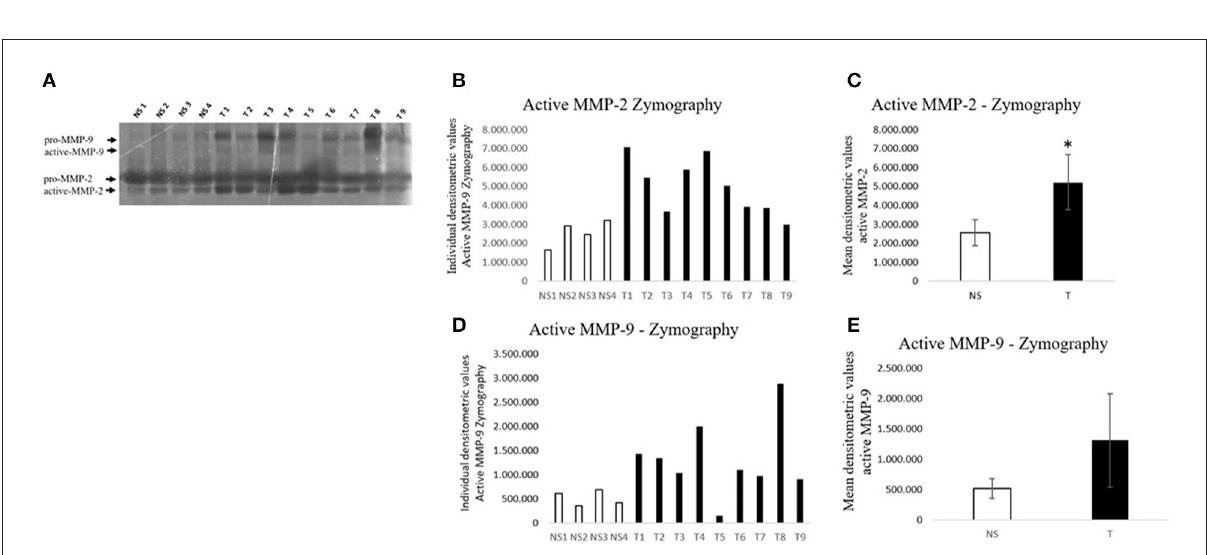
FIGURE10 Zymographic assay of gelatinases activity in bovine fibropapillomas (T) and normal skin (N) samples (A–E) . (A) In all fibropapillomas, MMP-2 is present in both proform (72 kDa) and active form (62 kDa); in fibropapillomas the active form of MMP-9 (82 kDa) is present at higher levels. (B,D) Individual densitometric values of active MMP-2/-9 for each sample. (E) Mean densitometric values + /- standard deviations for active MMP-2/-9 in NS vs. T groups (*: statistically significant by t -test, P < 0.05).